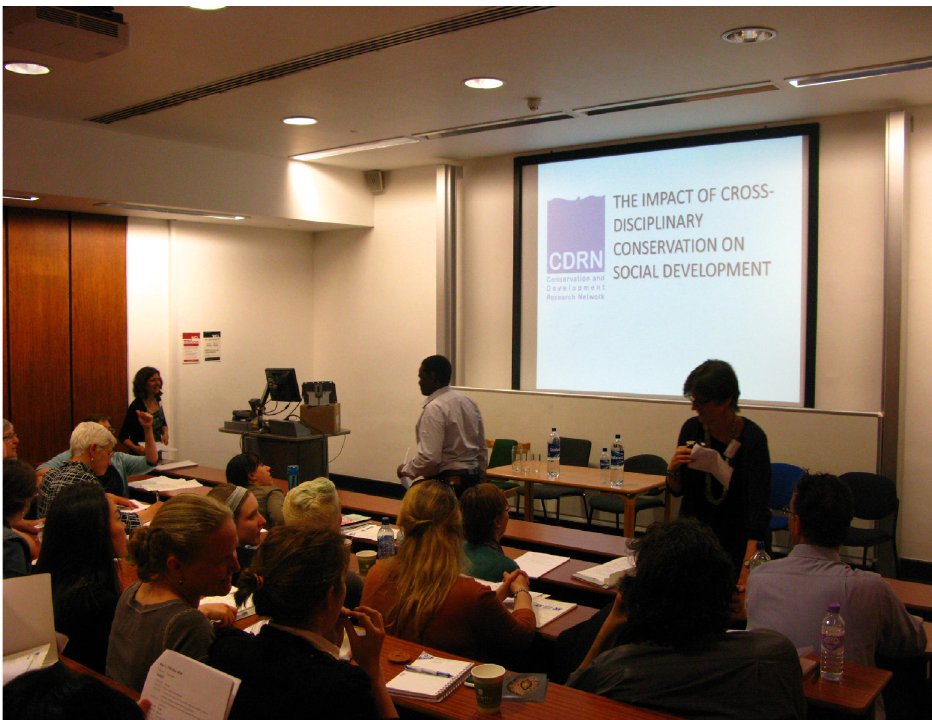
Fig. 1: Discussion during the conference on ‘The Impact of Cross Disciplinary Conservation Practices on Social Development’ May